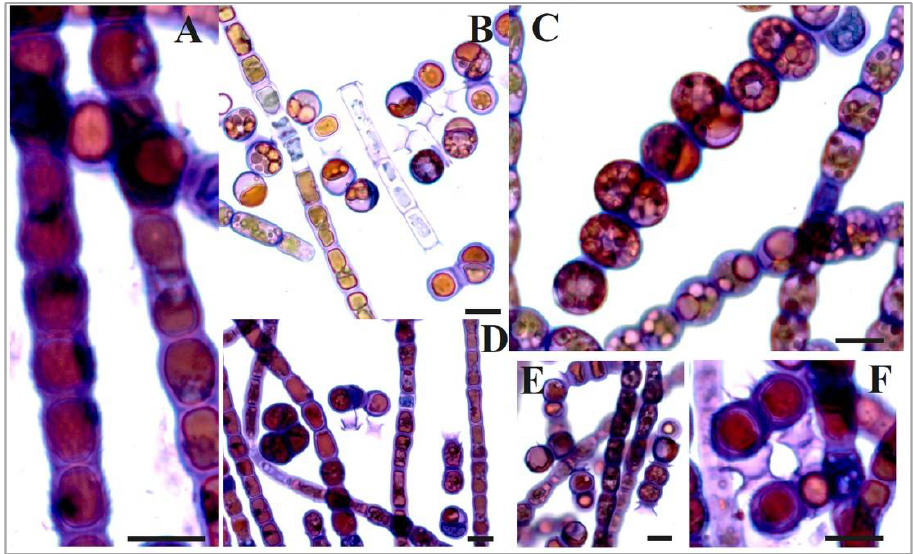
Figure 6. The cell wall of aging cells of IRK-A 341 (stained with gentian violet). ( A – C ). Filaments cells with striated ( A ) and smooth ( B – E ) thickening cell wall. ( B , D – F ) H-pieces at the ends of filaments, and caps remaining after the release of resting cells from filaments. Scale bars: 10 µm .